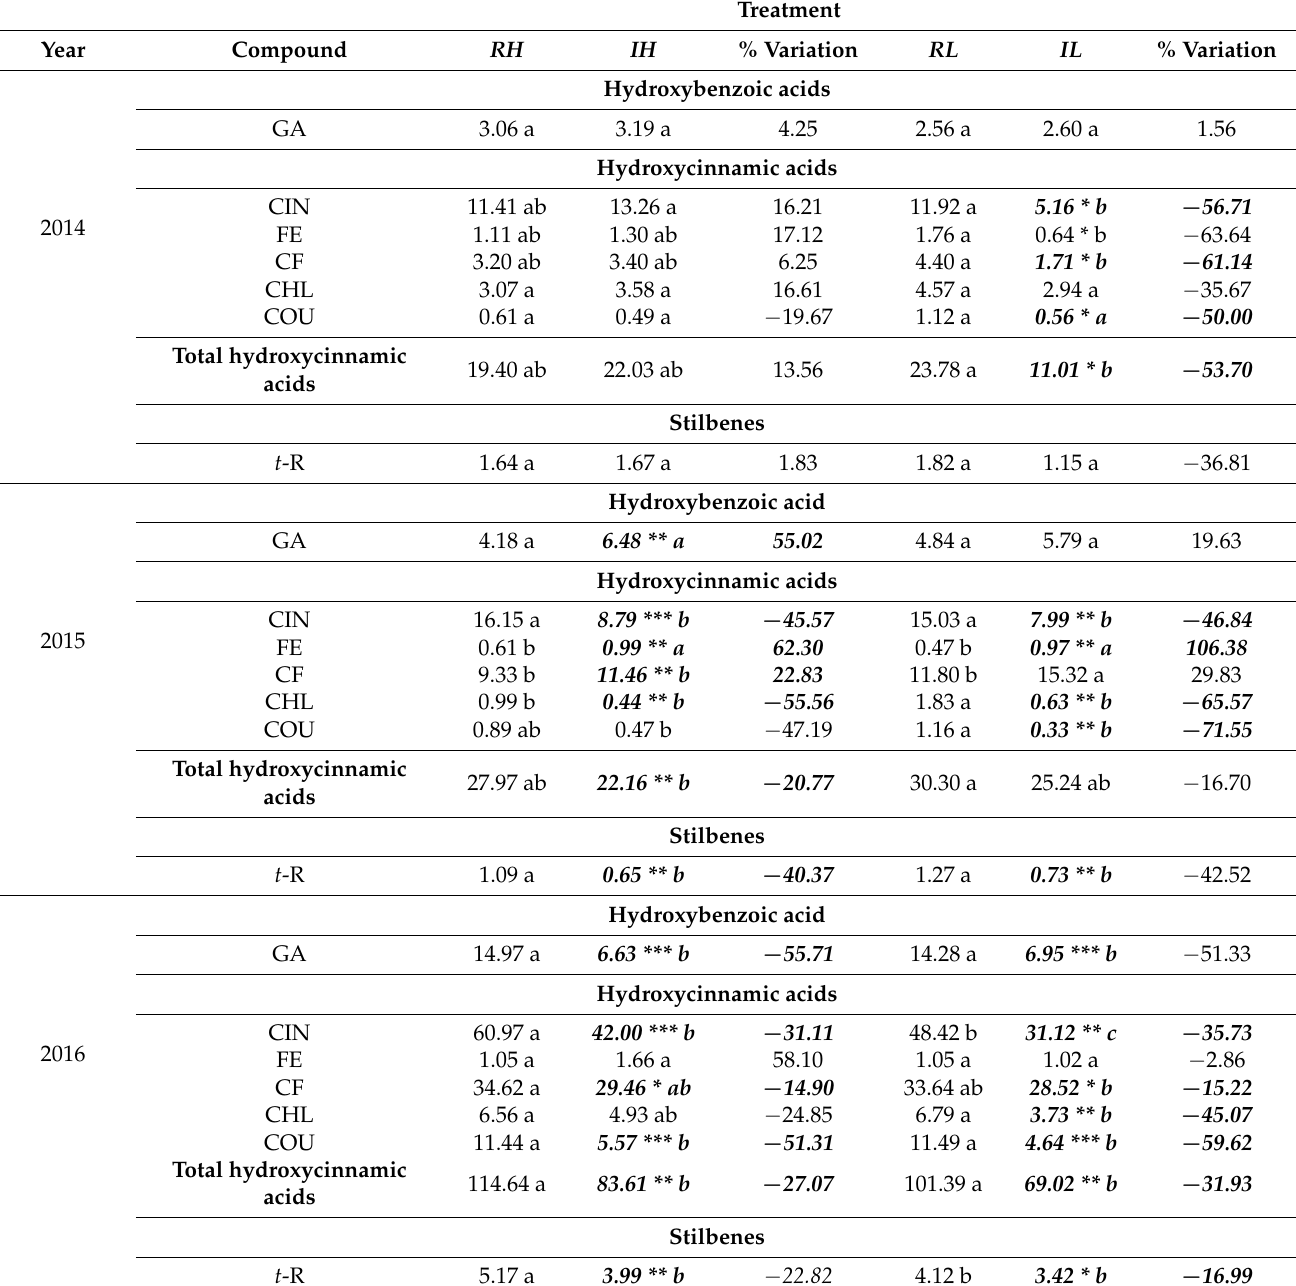
Table 7. Influence of irrigation on concentration of non-flavonoids compounds (mg. kg − 1 berry fresh weight) under two crop load levels. R : rainfed; I : non-limiting irrigation; H : high crop load; L : low crop load. GA: gallic acid; CIN: cinnamic acid; FE: ferulic acid; CF: caffeic acid; CHL: chlorogenic acid; COU: p -coumaric acid; t-R: